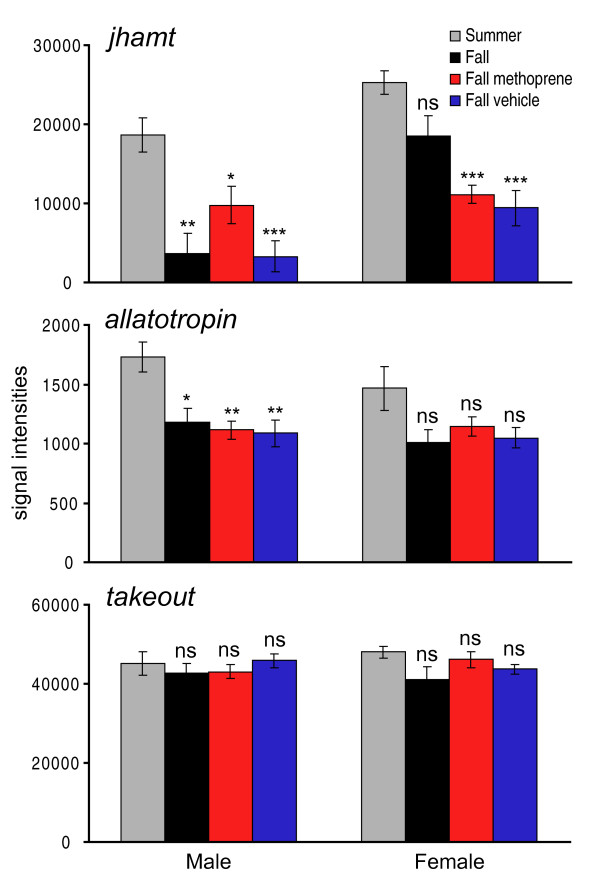
Comparison of sex-specific microarray expression profiles of juvenile hormone acid methyltransferase (jhamt), allatotropin, and takeout. The profiles were compared across the four experimental groups. For each sex, each of the three fall groups was compared with summer, using unpaired 2-tail t test (with unequal variance). ns, not significant, p > 0.05; * p < 0.05; ** p < 0.01; *** p < 0.001.